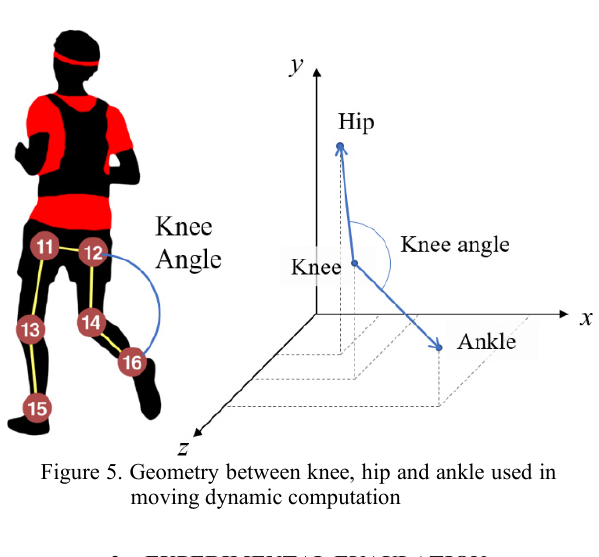
Figure 5. Geometry between knee, hip and ankle used in moving dynamic computation